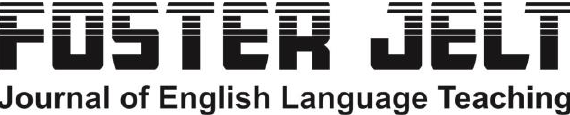
Figure 1. Lexical semantic error